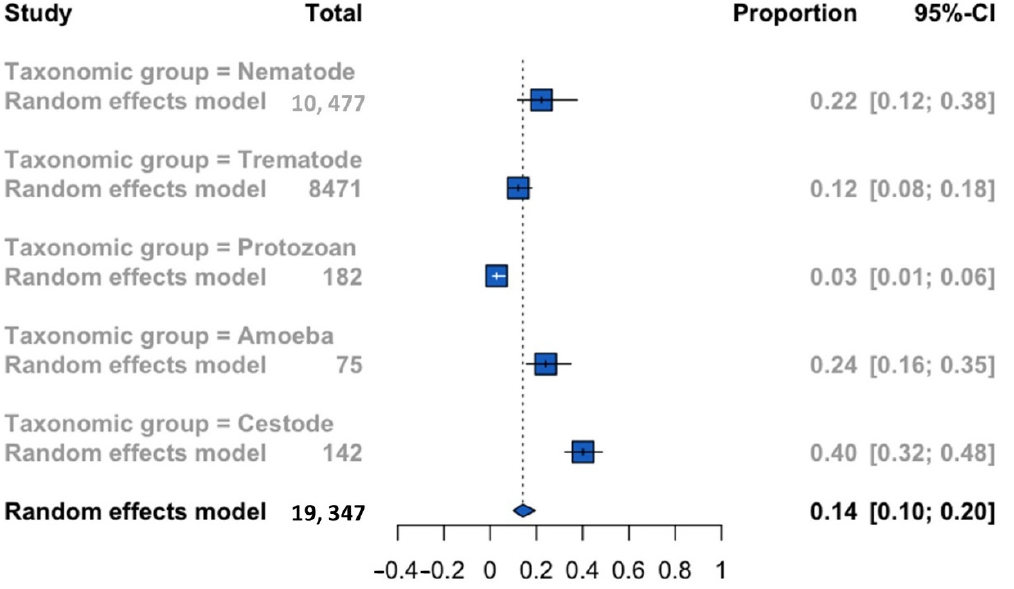
Figure 2. Forest plot of the global prevalence of parasitic infections with zoonotic potential in tilapia according to the taxonomic group.